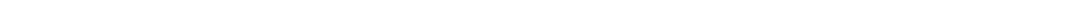
Fig. 6 Enhanced cellular proliferation mediated by IL-13R α 2 is speci fi c to EGFRvIII, and not WT EGFR. a U251-E6 or c U251-E18 cells were treated with or without tetracycline (Tet). At indicated time points, immunoblot analysis was carried out. Gli36, Gli36.EGFRvIII cell lysates were included as negative or positive controls for EGFRvIII, respectively. Growth kinetics of b U251-E6 and d U251-E18 was determined by CCK-8 assay. Percent cell viability was normalized to day 1 (without induction). All data are represented as mean ± SEM. Unpaired t -test *** p < 0.001, NS. not signi fi cant. e Co- immunoprecipitation was performed in stable cell lines Gli36.IL-13R α 2/wtEGFR as well as U251MG-E6 (i.e. wtEGFR) cells at 48 h post tetracycline induction with the indicated antibodies. Gli36.IL-13R α 2/EGFRvIII served as positive controls. f The interaction between endogenous wtEGFR and IL-13R α 2 was shown in primary wtEGFR-positive GBM patient tumor derived from Mayo clinic, and IgG served as positive and negative controls respectively. Knockdown of IL-13R α 2 in cell line or patient-derived GBM samples expressing g wtEGFR or h